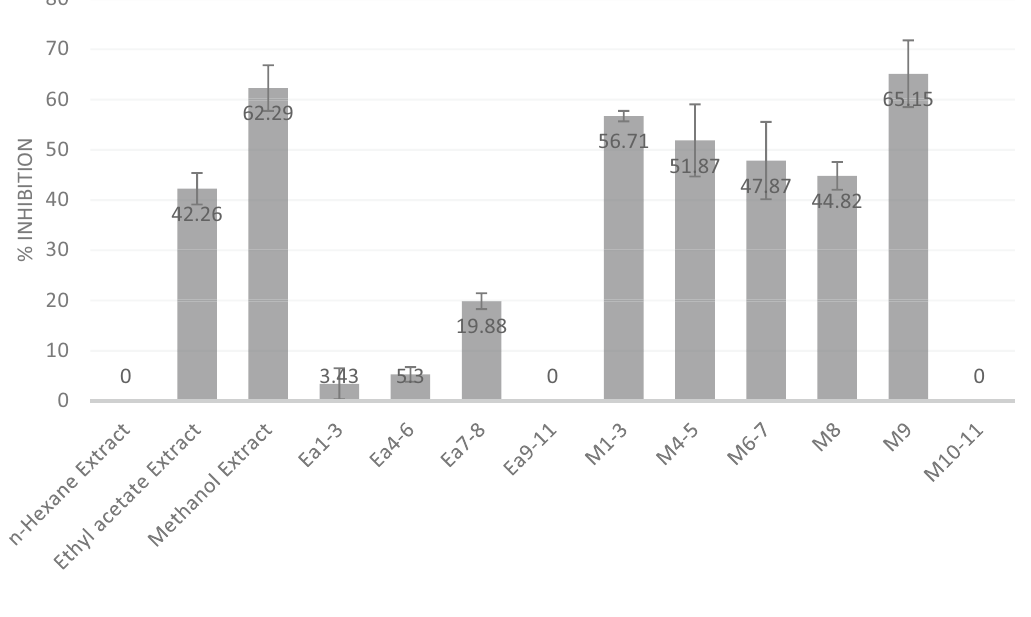
Figure 1. Elastase inhibition by R. fraxinifolius leaf extracts and